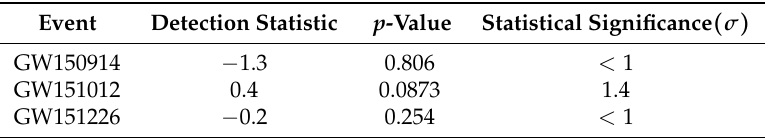
Table 17. The detection statistic and its corresponding statistical significance and p -value for O1 events [145]. The ordering of events by their statistical significance is consistent with what reported by Nielsen et al.